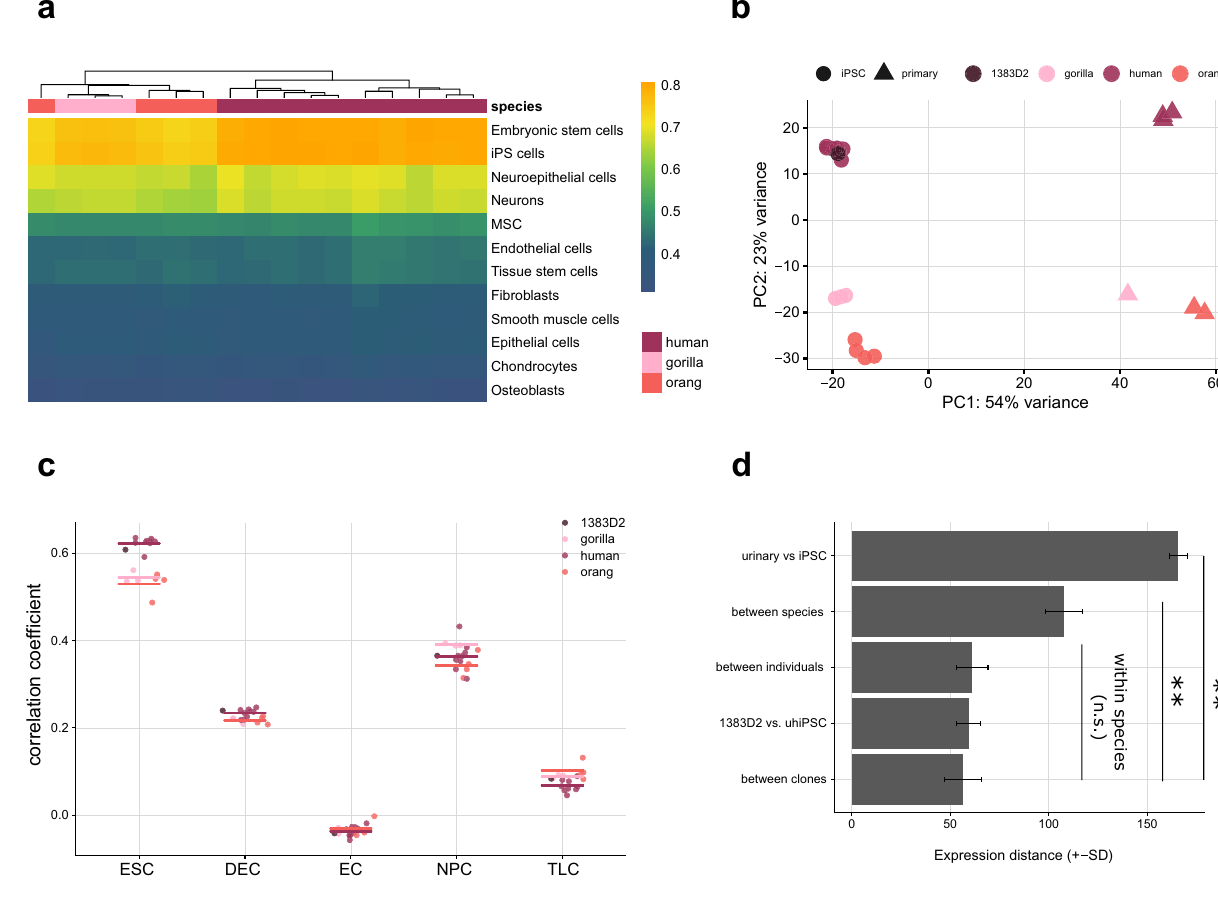
Figure 5. Characterization of primate iPSCs by expression profiling. ( a ) The package SingleR was used to correlate the expression profiles from seventeen samples of primate iPSCs (passage 1–3) to a reference set of 38 human cell types. The twelve cell types with the highest correlations are shown ( MSC mesenchymal stem cells). All lines are similarly correlated to embryonic stem cells and iPS cells. Color bar indicates correlation coefficients. ( b ) Principal component analysis of primary cells and derived iPSC lines using the 500 most variable genes. PC1 separates the cell types and PC2 separates the species from each other. ( c ) Correlation coefficient of iPSCs compared to a single cell dataset covering distinct human embryonic stem cell derived progenitor states (Chu et al. 2016). ( d ) Expression distances of all detected genes are averaged from pairwise distances for six different groups of comparisons. Note that the distance between individuals and between species is calculated within iPSCs and distances between individuals within species. Pairwise t-tests are all below 0.01 (**) for comparisons to the cell-type and species distance and all above 0.05 (n.s.) for comparisons within the species. See also Supplementary Figure